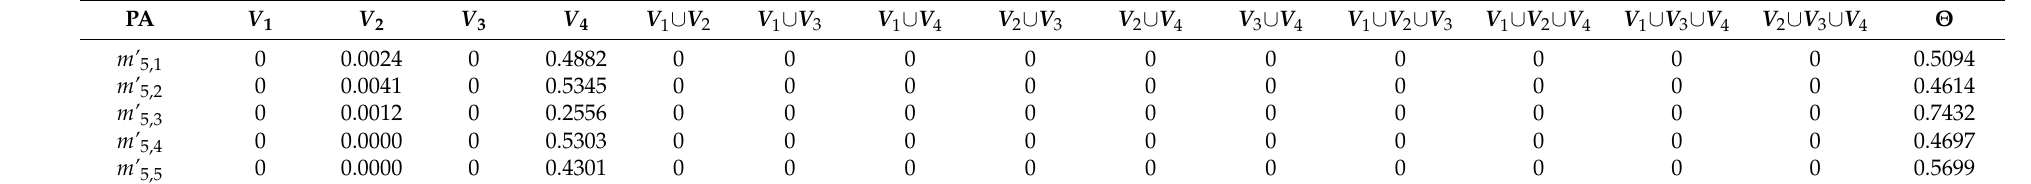
Table 15. Probability assignments of longitudinal crack-oblique crack sub-classifier for an image of a transverse crack.